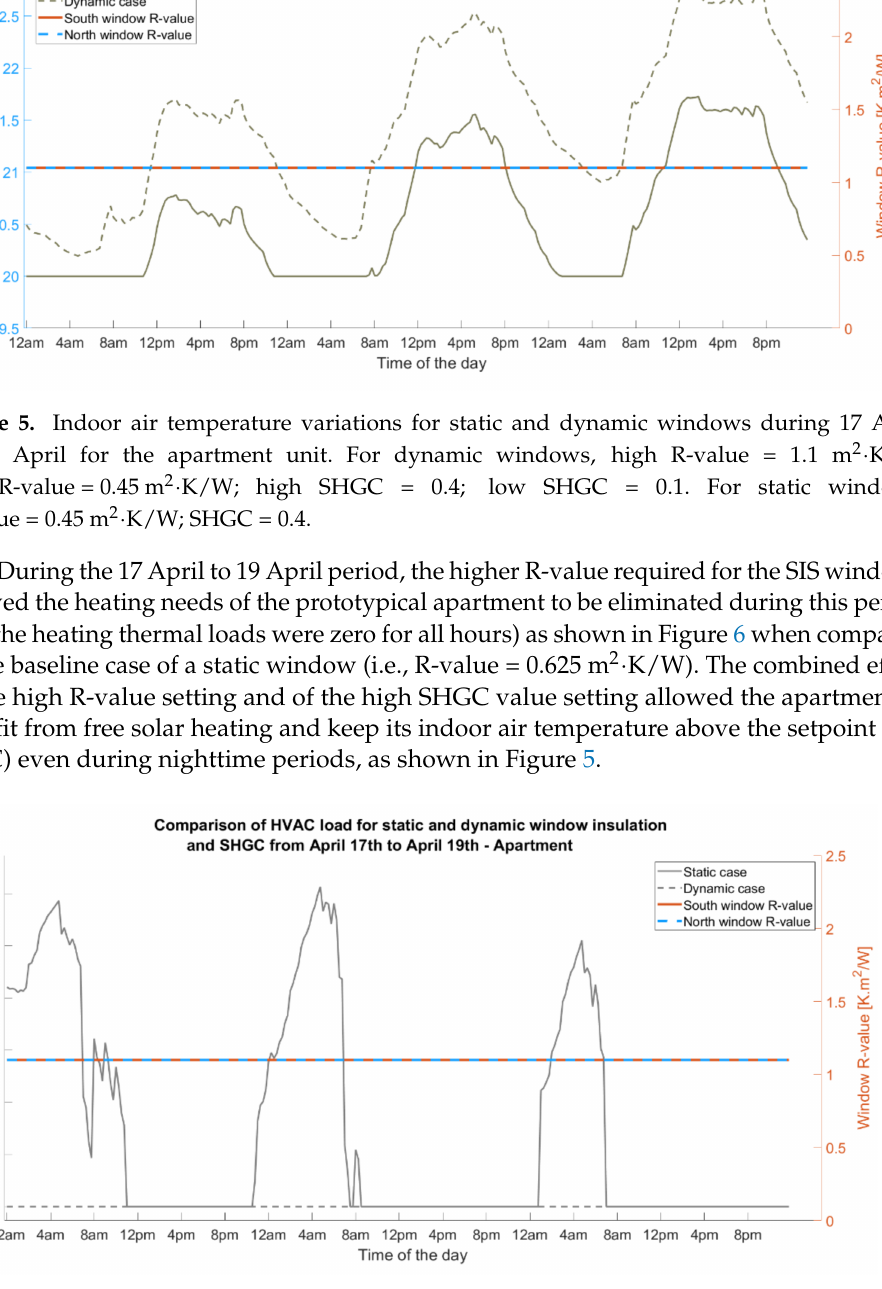
Figure 6. Comparison of HVAC loads for static and dynamic windows from 17 April to 19 April for the prototypical apartment unit. For dynamic windows, high R-value = 1.1 m 2 · K/W; low R-value = 0.45 m 2 · K/W; high SHGC = 0.4; low SHGC = 0.1. For static windows, R- value = 0.45 m 2 · K/W; SHGC =